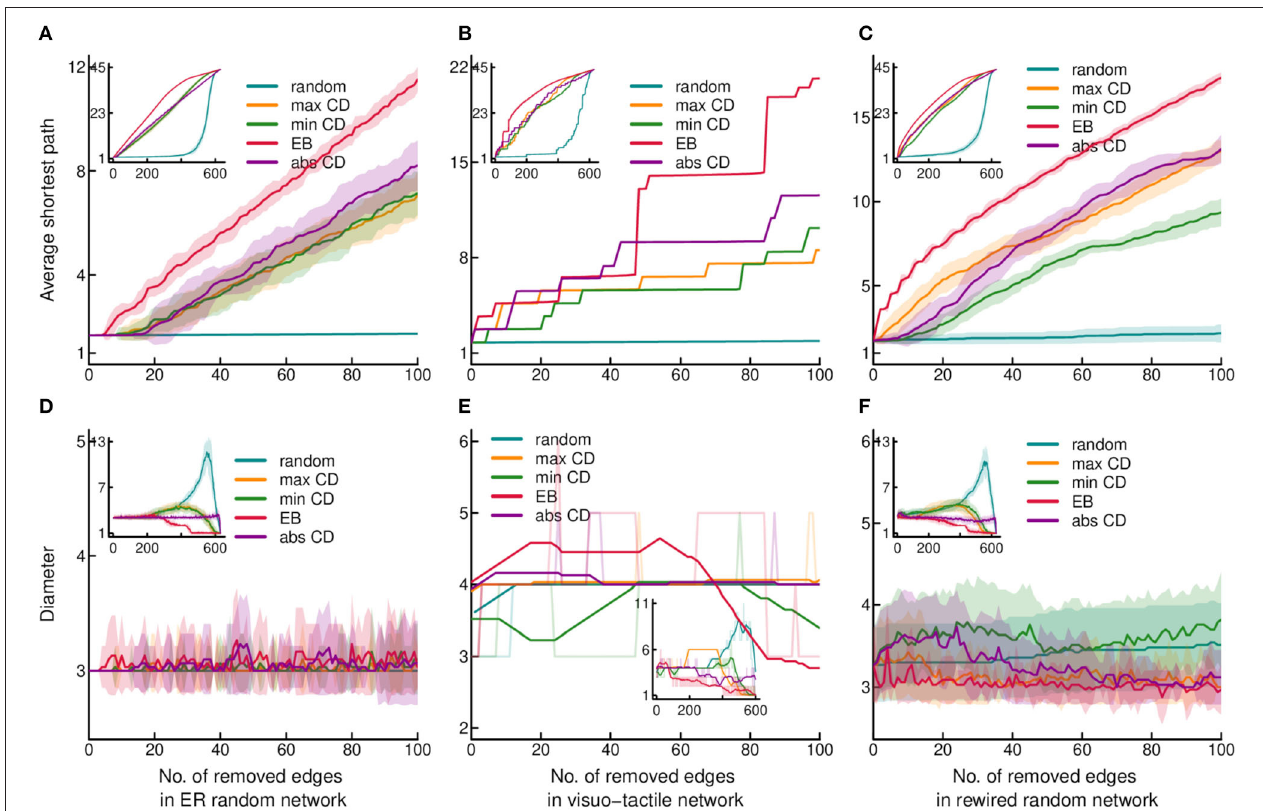
FIGURE 2 | Effect of edge removal on global network efficiency. (A–C) present changes of the average shortest path, while (D–F) show changes of the diameter, as the function of stepwise edge removals. Changes in diameter were smoothed by moving average with a 31 step window size. However, the non-smoothed original data is also indicated by the lighter coloring of the lines. All the conventions and the layout of the plots are the same as in Figure 1